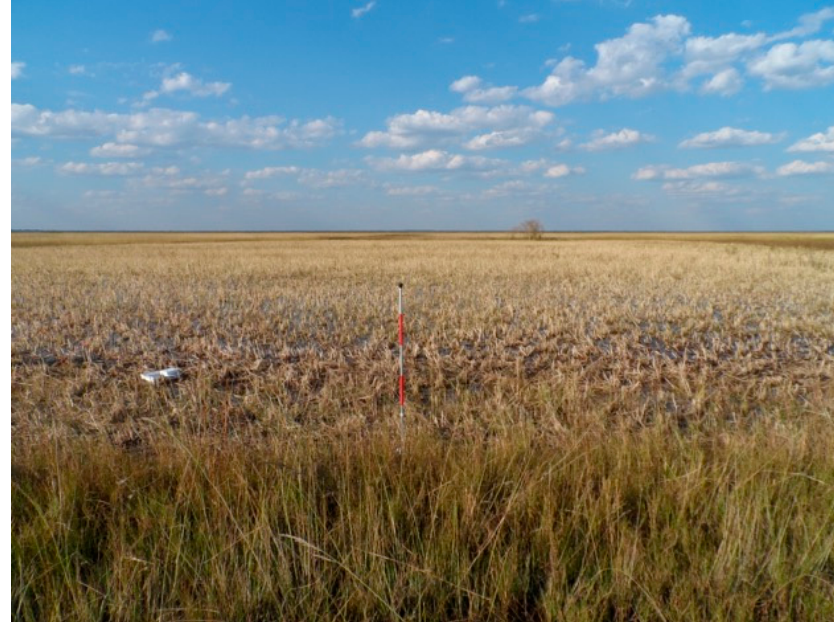
Figure 9. Example vegetated water body (raised peat bog or ‘dambo’) successfully classified, characterised by relatively short grasses. Image from June 2018 long: 23.32, lat: − 15.14. Ranging pole with 5 × 20 cm sections from base. Water depth = 5 cm.